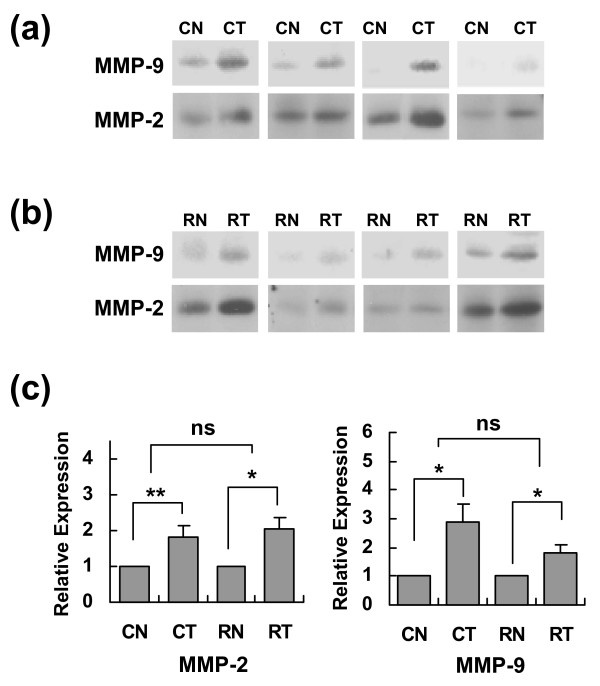
The expression of MMP-2 and MMP-9 in tumor tissuesand adjacent normal mucosa of colon and rectal cancer patients. (a) Representative Western blot analysis of colon tumor (CT) and the corresponding paired adjacent normal colonic mucosa (CN) from colon cancer patients. (b) Representative Western blots of rectal tumor (RT) and the corresponding paired adjacent normal rectal mucosa (RN) from rectal cancer patients. (c) Band densities from all tissue samples were quantified and the relative expression of MMP-2 and MMP-9 are expressed as a mean ± SE. ns, non-significant. *P < 0.05. **P < 0.01.